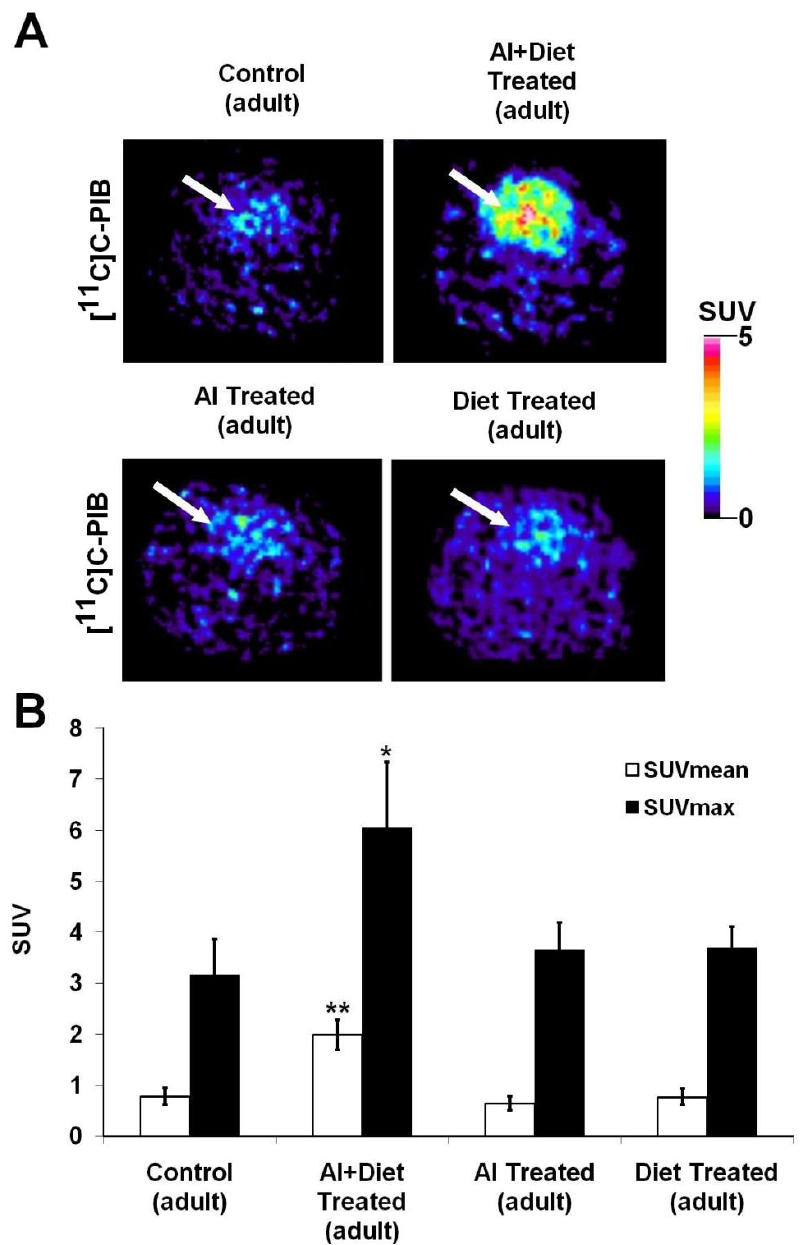
Figure 3. Comparison of cerebral [ 11 C]C-PIB radiopharmaceutical uptake of the elderly animals administered with monotreatment (cholesterol or Al 2 (SO 4 ) 3 ) and combined (cholesterol and Al 2 (SO 4 ) 3 ) treatment to each other and to the control healthy group of old rats. ( A ) Shows the transaxial PET images of the old animals receiving standard chow and normal tap water (upper row, left), combined treatment (upper row, right), and Al-containing (lower row, left) or cholesterol-enriched (lower row, right) monotreatment. ( B ) Demonstrates the results of the quantitative SUV analysis of [ 11 C]C-PIB uptake of the control, the monotreated rats and those receiving combined treatment. SUV values are presented as mean ± SD. Significance level (compared to the untreated control and monotherapy groups): p ≤ 0.05 (*) and p ≤ 0.01 (**). [ 11 C]C-PIB: [ 11 C]C Pittsburgh compound B; PET: Positron Emission Tomography; Al: aluminium; SUV: standardised uptake value; SD: standard deviation. White arrow: brain.